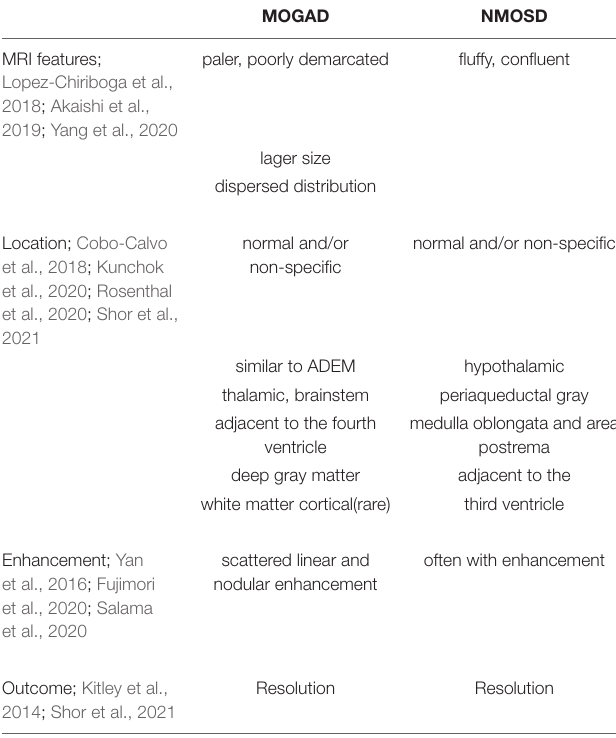
TABLE 2 | Brain MRI features comparison between MOGAD and